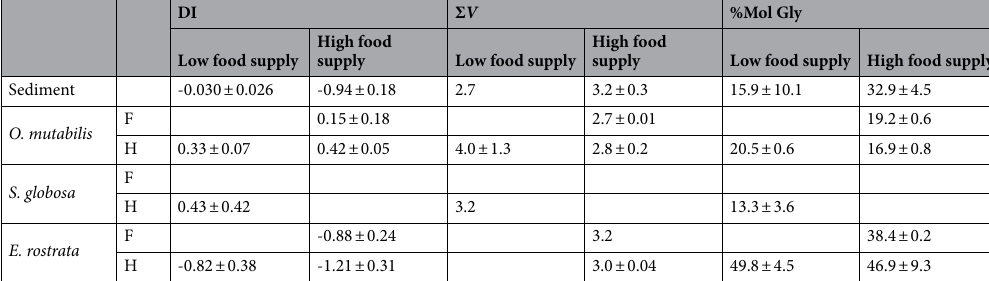
Table 2. Degradation index (DI), Σ V parameter, and %Mol Gly in surface sediments (0–5 mm) and gut contents (F: foregut; H: hindgut) of deposit feeders (mean ± SD) collected in periods of low food supply (i.e. May) and high food supply (i.e. October). The sample size was two for each mean value, and for those values not including standard deviation the parameter was calculated from one